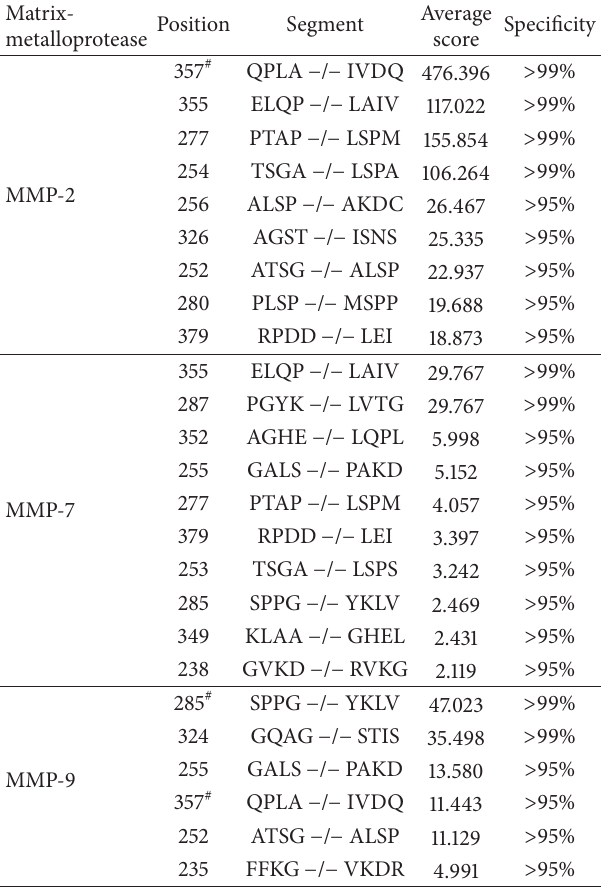
Table 1: Results of cleavage site prediction based on SitePredic- tion ∗ in silico analysis.